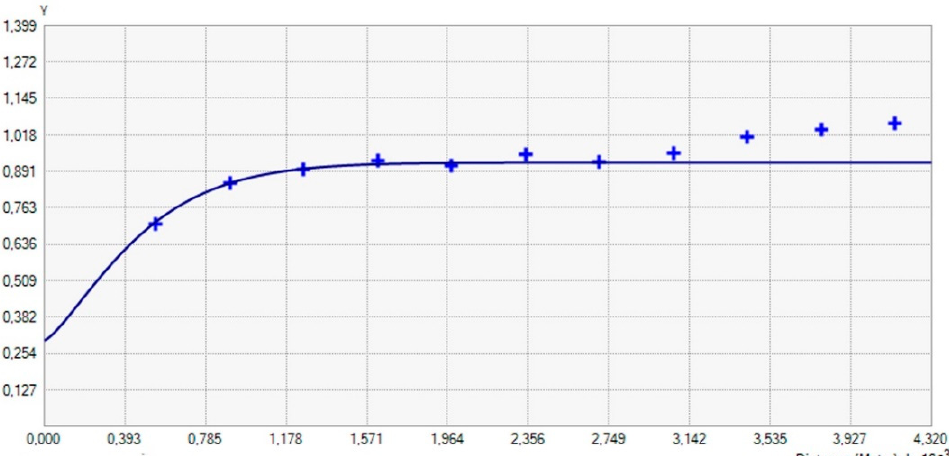
Figure A1. Experimental semivariogram (symbols) and models (line) for total concentration of Pb in the topsoil layer—PMNet.